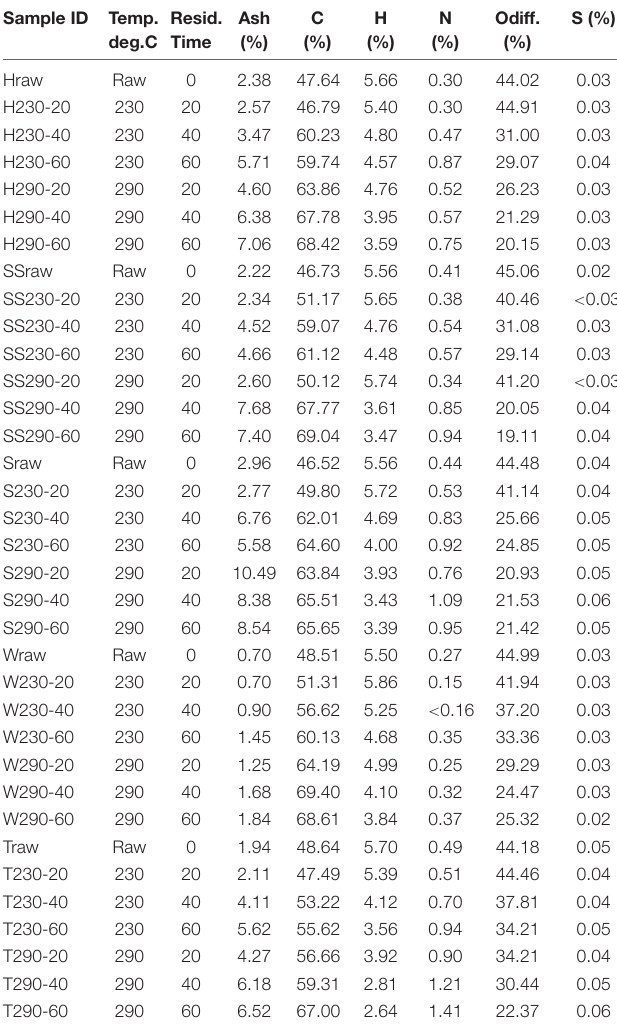
TABLE 1 | CHNSO elemental and ash composition of raw and torrefied H, SS, S, T, W samples. Sample ID Temp. Resid. deg.C Time